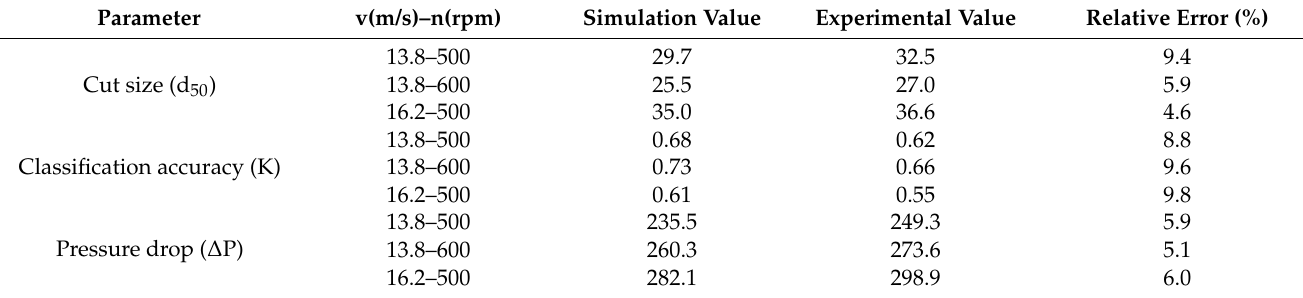
Table 6. The cut size, classification accuracy, and pressure drop for the experiment and simulation.